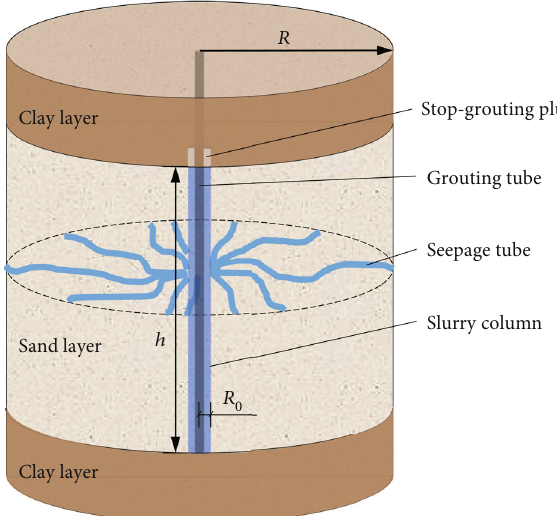
Figure 1: Cylindrical di ff usion model of radial tube fl